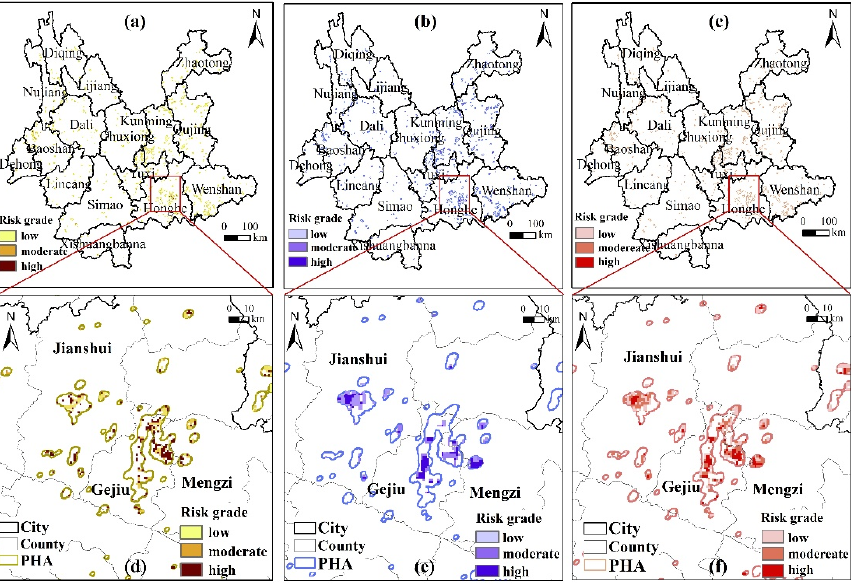
Figure 6. The 1 km scale risk assessment for ( a ) cropland, ( b ) sensitive populations, and ( c ) overall risk in Yunnan. In Honghe City, the risk assessment is shown for ( d ) cropland, ( e ) sensitive populations, and ( f ) overall risk. PHA is the potentially hazardous area simulation.